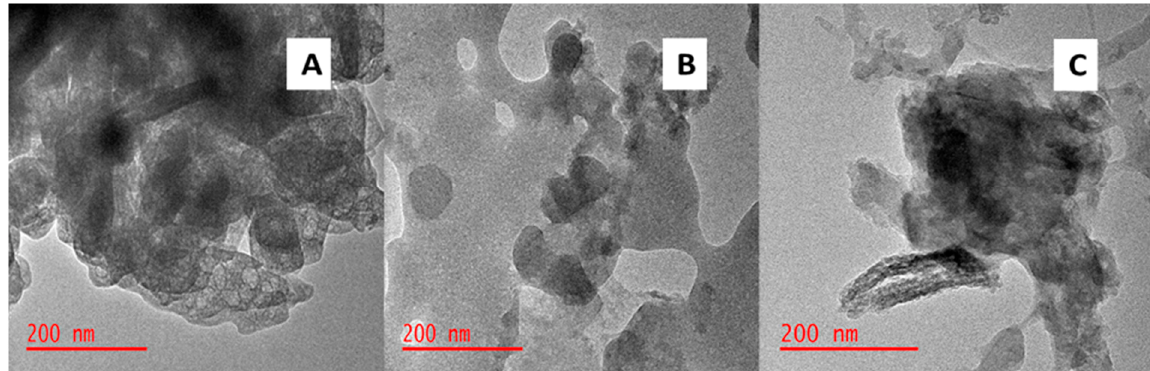
Figure 3. TEM images of ( A ) BPAC, ( B ) Al 2 O 3 , and ( C ) BPAC@Al 2 O 3 @chitosan.